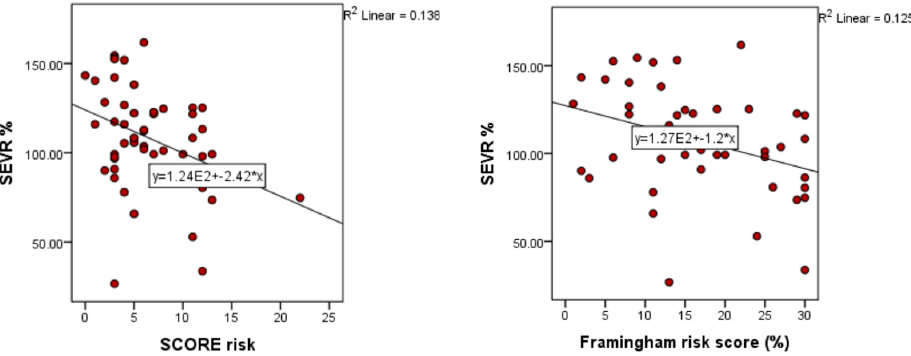
Figure 4. Correlation of SEVR values with SCORE risk values and Framingham risk score values (SEVR: subendocardial viability ratio) .